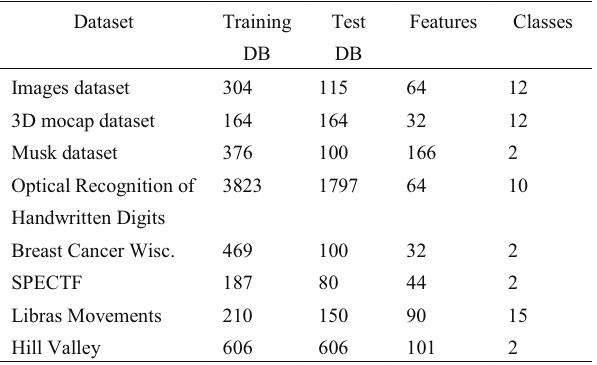
Table 1. Characteristics of the datasets. Table 2. Discovered contrast sets of the Image